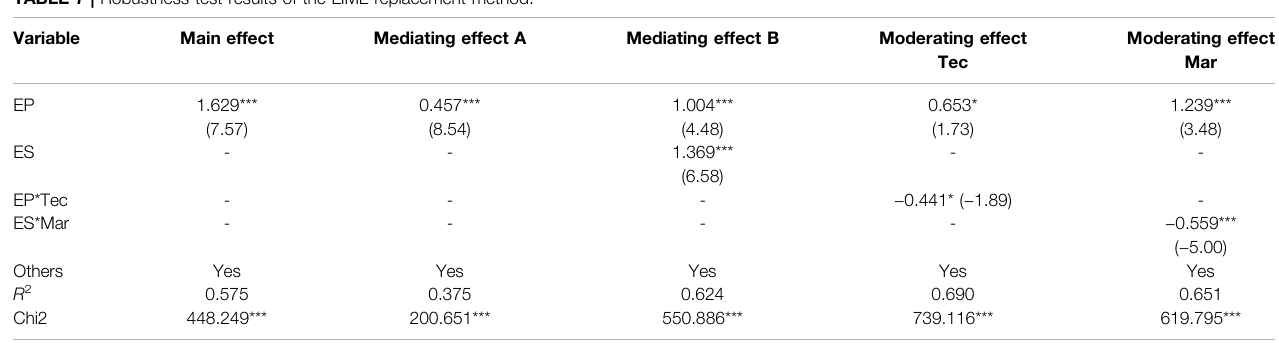
TABLE 7 | Robustness test results of the LIML replacement